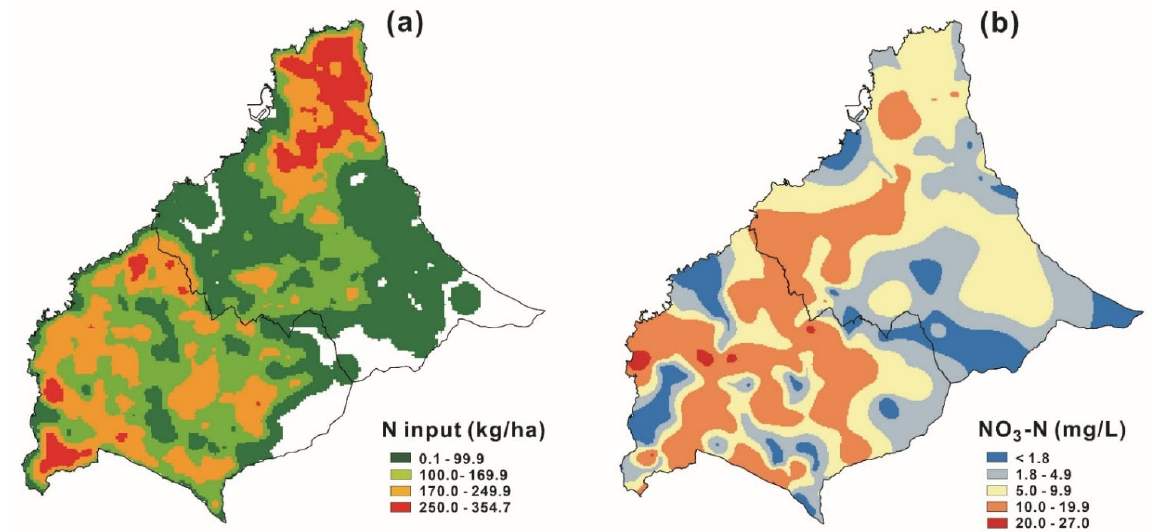
Figure 5. Map of ( a ) spatially interpolated N input and ( b ) groundwater NO 3 ‐ N level over the study area.